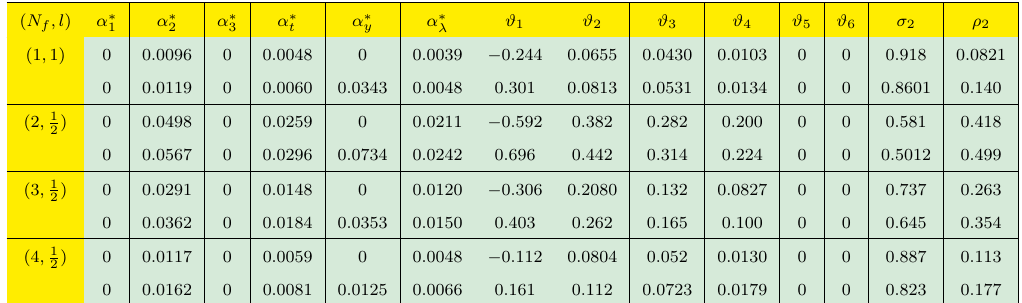
Table 4 . Fixed points and eigenvalues for colorless vector-like fermions, in the 321 approximation scheme. The last two columns give the values of the ratios (cid:27)